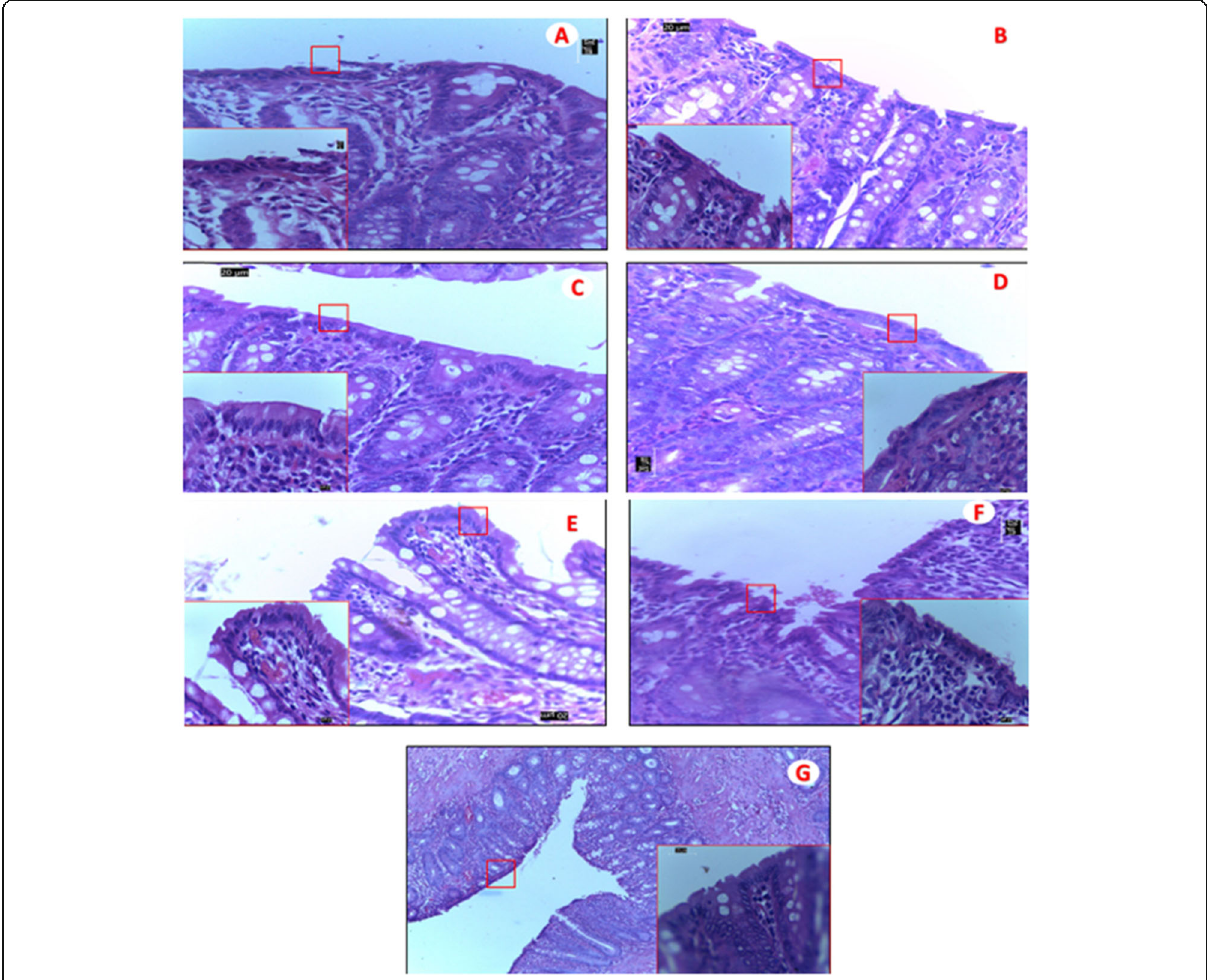
Fig. 6 Hematoxylin and eosin-stained sections of mice rectum. Light micrographs (× 400 and × 1000 (red square) of the rectal mucosa of mice after 14 days of daily treatment with 0.04 mls of 1:20 dilution. a Bigel A. b Bigel B. c Bigel C. d Bigel D. e Bigel without drugs. f N9 gel. g No treatment. Photographs are representative of all treated mice ( n = 3 group). Original magnification ×